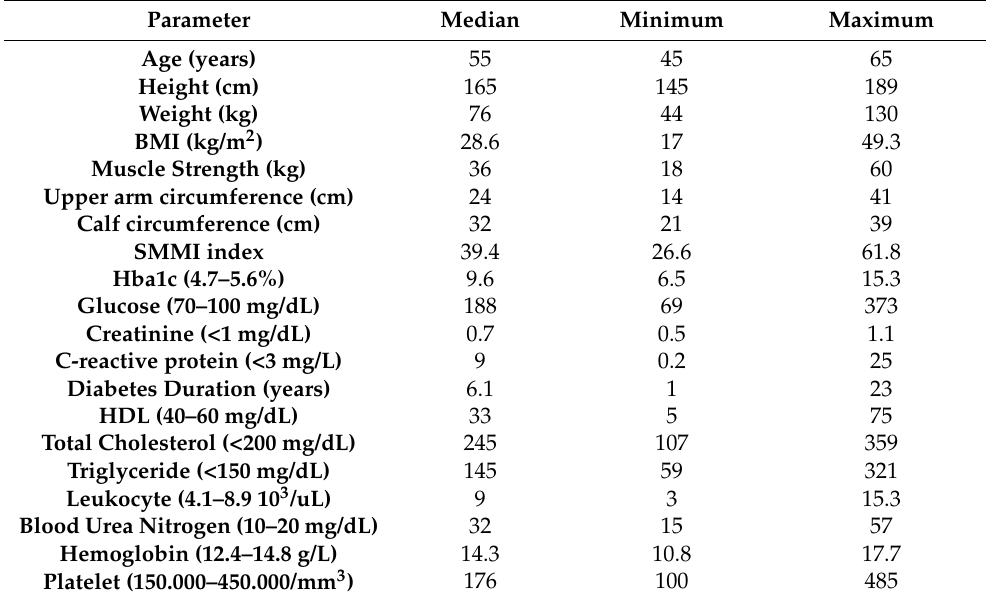
Table 1. Demographic data, anthropometric measurements, clinical and biochemical parameters of the patients.